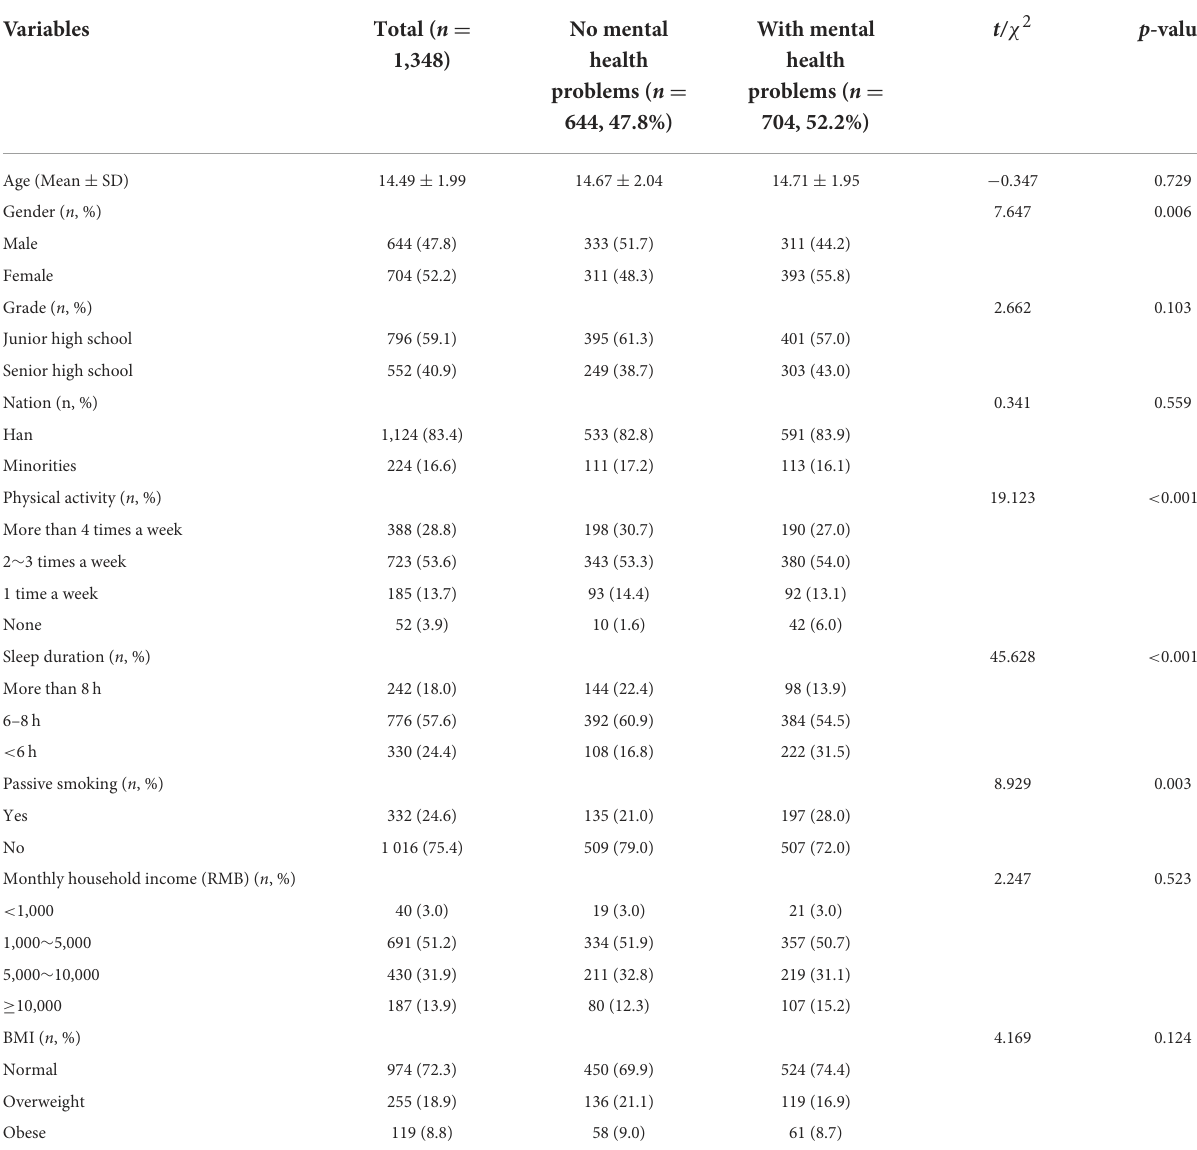
TABLE 2 Major characteristics of study population.